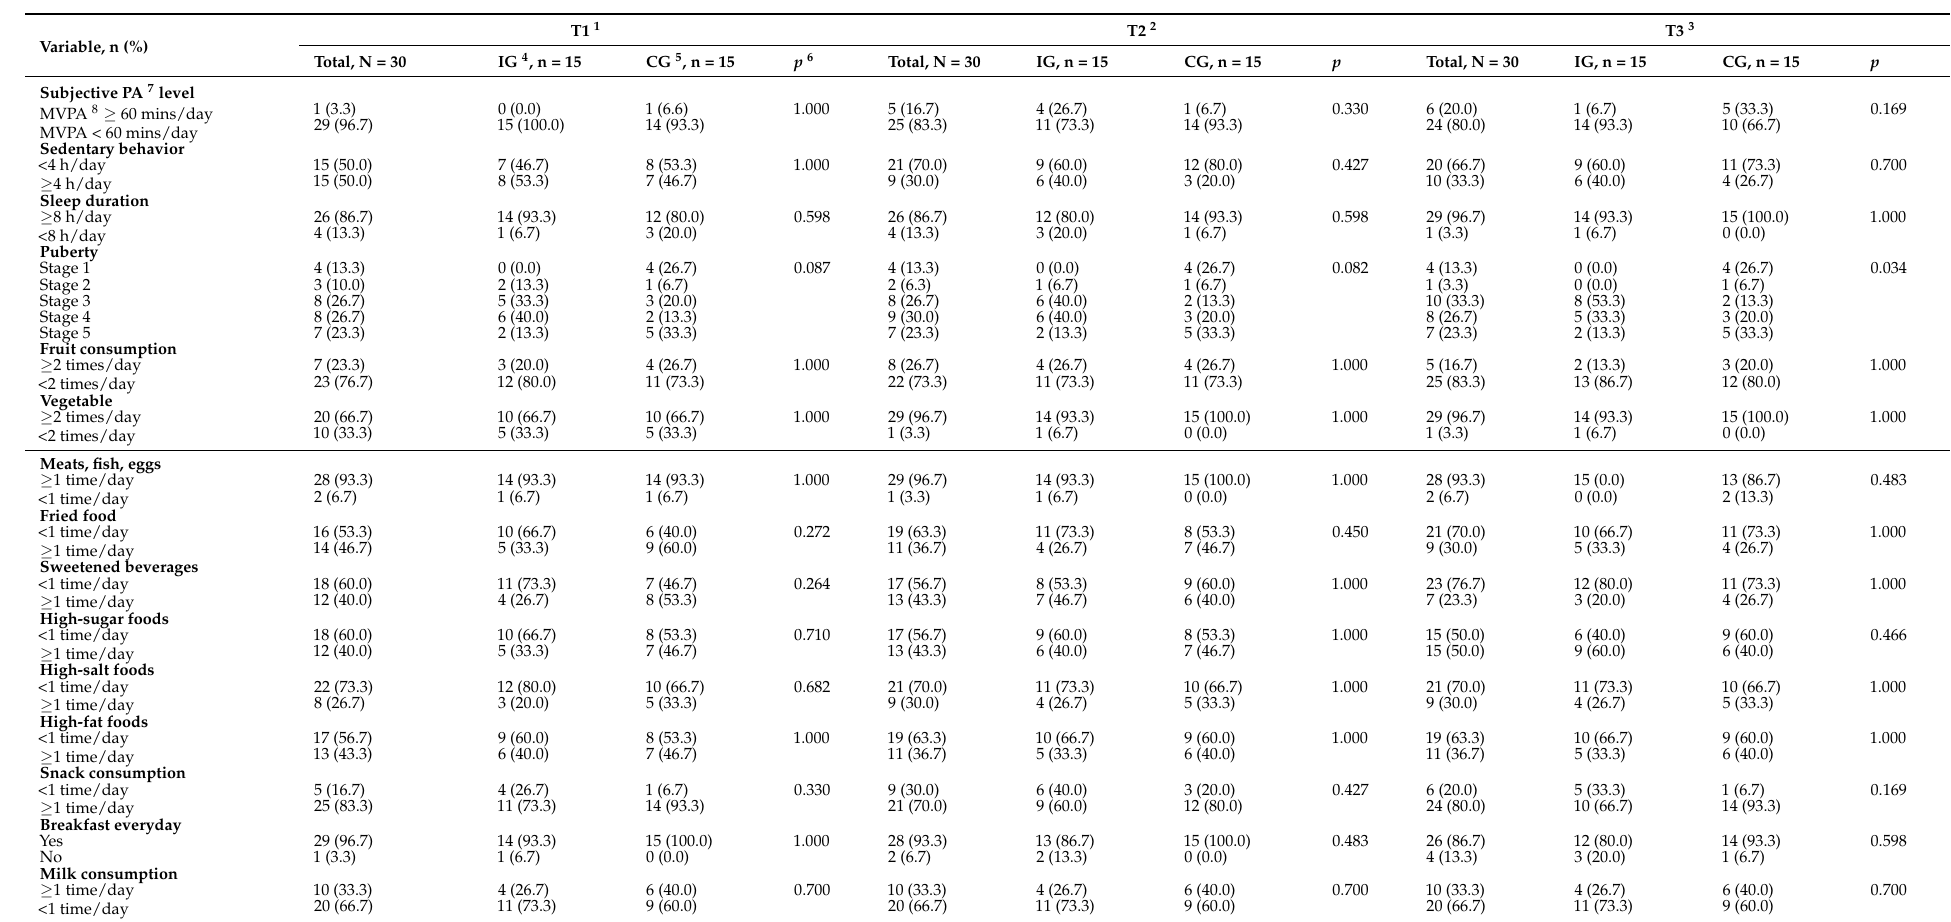
Table A2. Lifestyle confounders of the participants at T1, T2, and